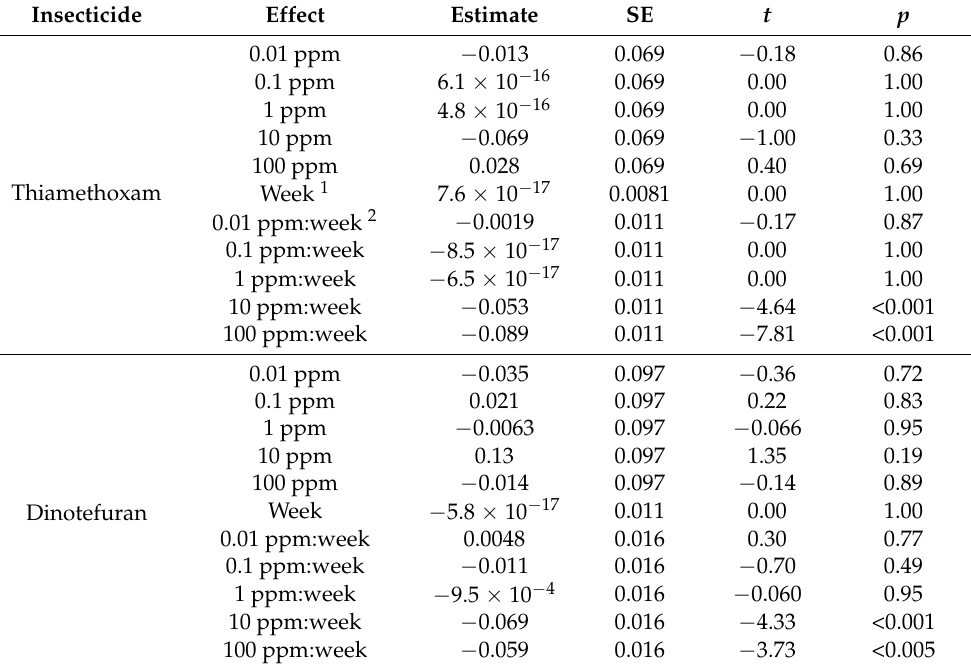
Table A3. Parameter estimates for GLMs to explain the survival rate of Aromia bungii late instar larvae.